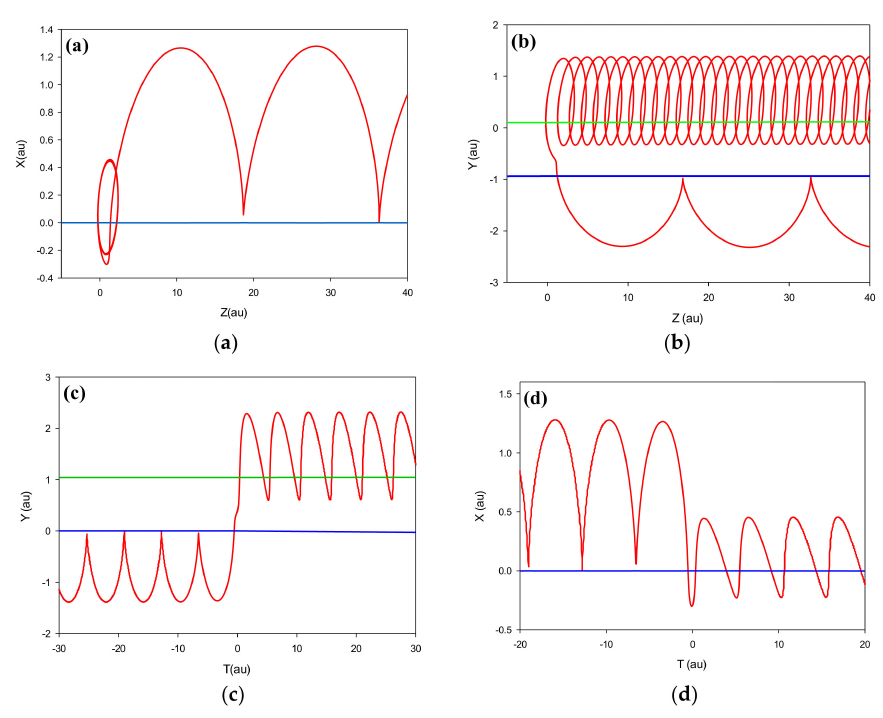
Figure 4. ( a ) Trajectories in the x-z projectile frame, ( b ) Trajectories in the y-z center-of-mass frame, ( c ) y position as a function of time in the lab frame, ( d ) x position as a function of time in the projectile frame for the electron (red line), projectile (green line) and target (blue line) for charge exchange channel for a typical Be 4 + with E = 900 keV /